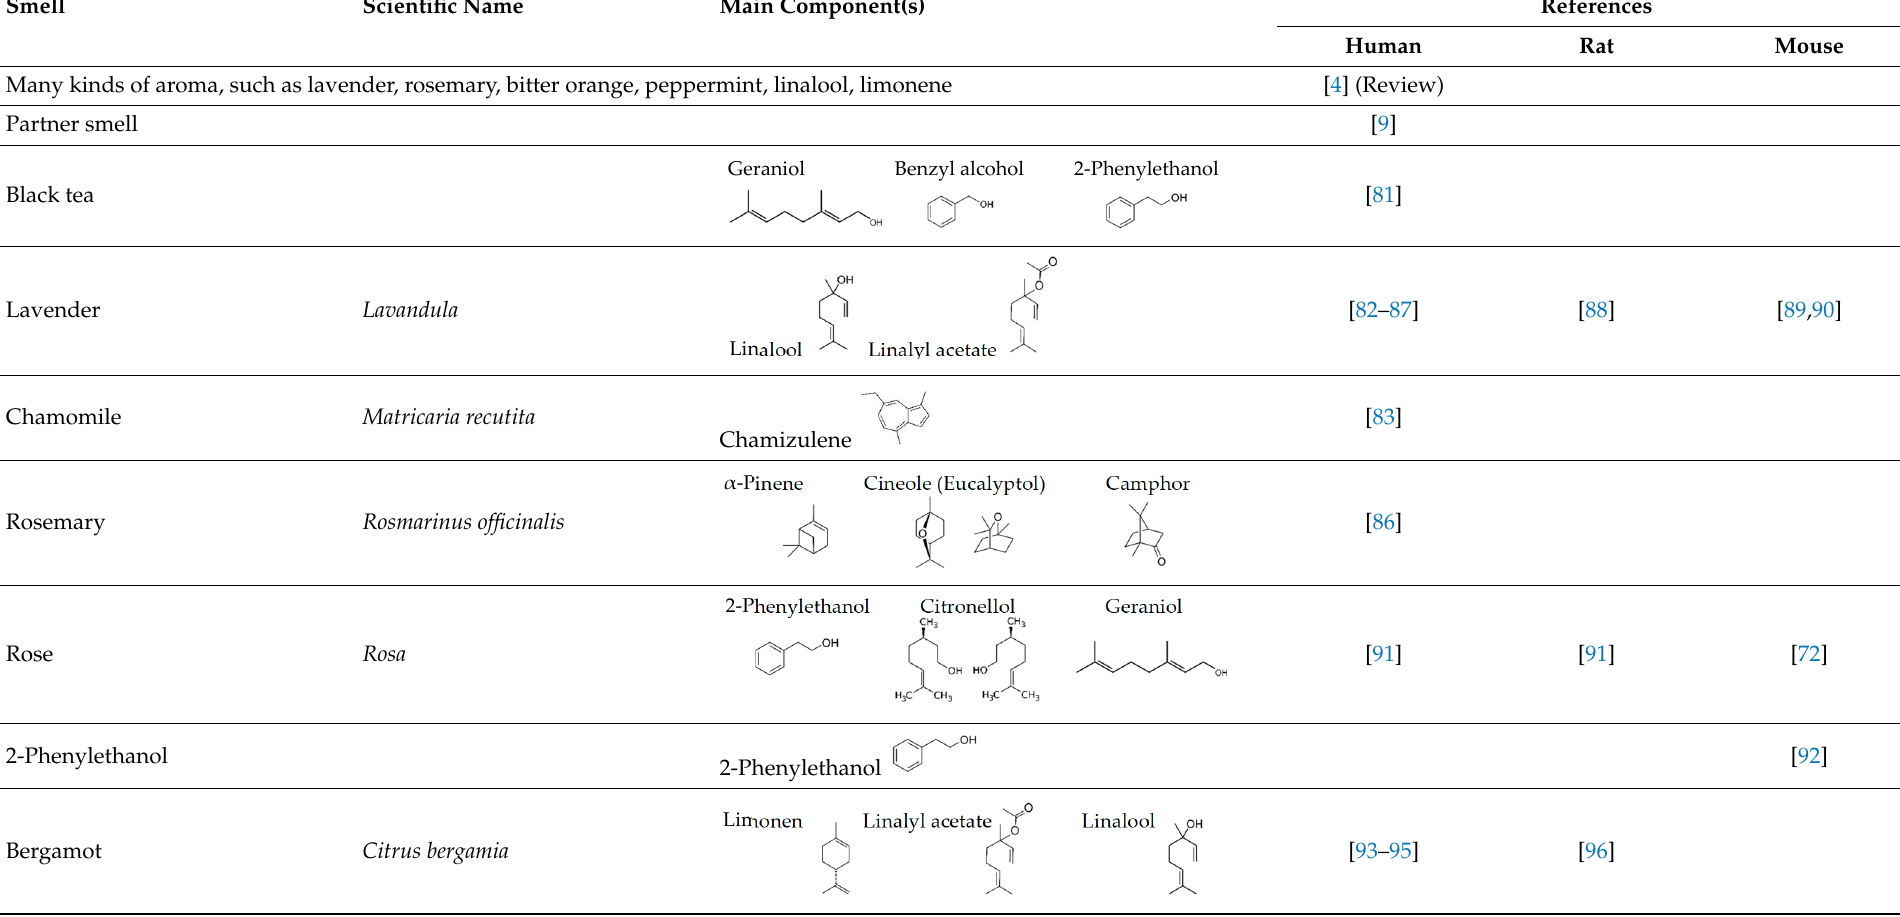
Table 1. Summary of smell and its main component(s) in previous studies. The scientific name of plants and the name of main component(s) are as described in the reference. A general name appears in the case of no indication in the article.